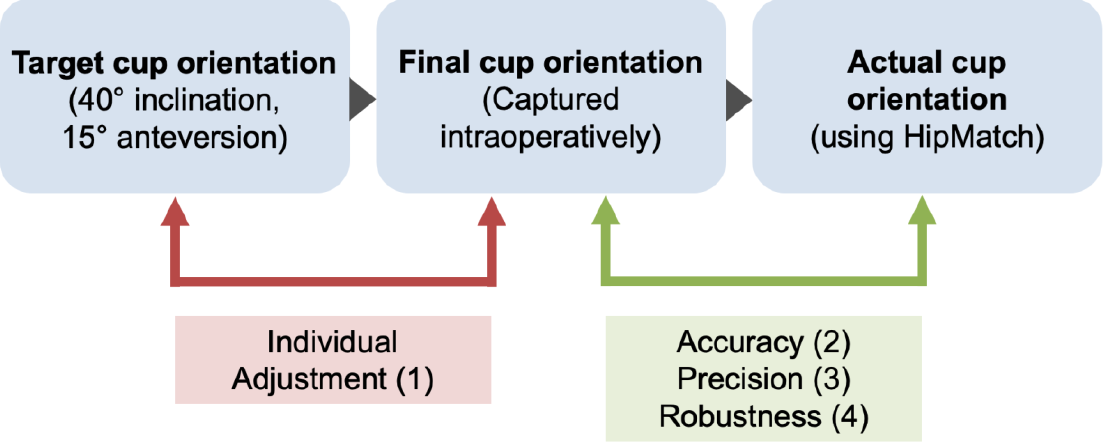
Figure 1. Overview of evaluation of the study results based on the three study questions.